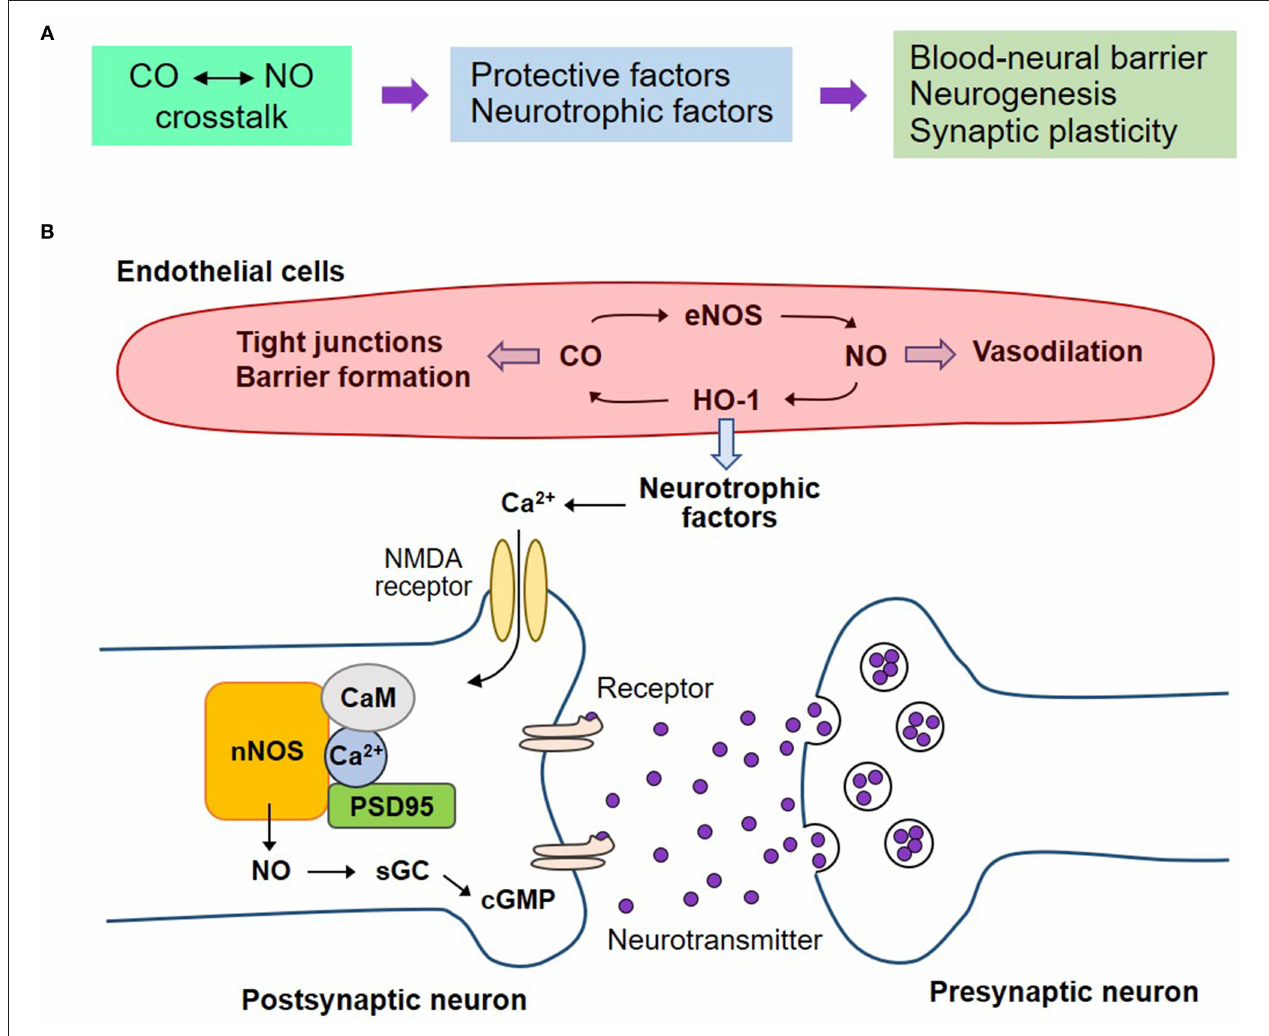
FIGURE 4 | Regenerative effects of CO on the neurovascular system by crosstalk with NO. (A) The crosstalk between CO and NO may potentiate the secretion of neurotrophic factors, consequently leading to blood-neural barrier maintenance, neurogenesis, and synaptic plasticity on the neurovascular unit. (B) Healthy blood vessels are maintained by moderate levels of CO by crosstalk with eNOS/NO pathway. NO reciprocally upregulates HO-1 expression, leading to CO production. The interplay of CO with NO affects vascular function by inducing blood-neural barrier and vasodilation. The endothelial cell-mediated neurotrophic factors may induce nNOS-mediated NO production and consequent sGC activation and cGMP production. These pathways can stimulate neurogenesis and synaptic plasticity. nNOS, neuronal nitric oxide synthase; CaM, calmodulin; PSD95, post-synaptic density 95; NMDA receptor, N-methyl-D-aspartate receptor.